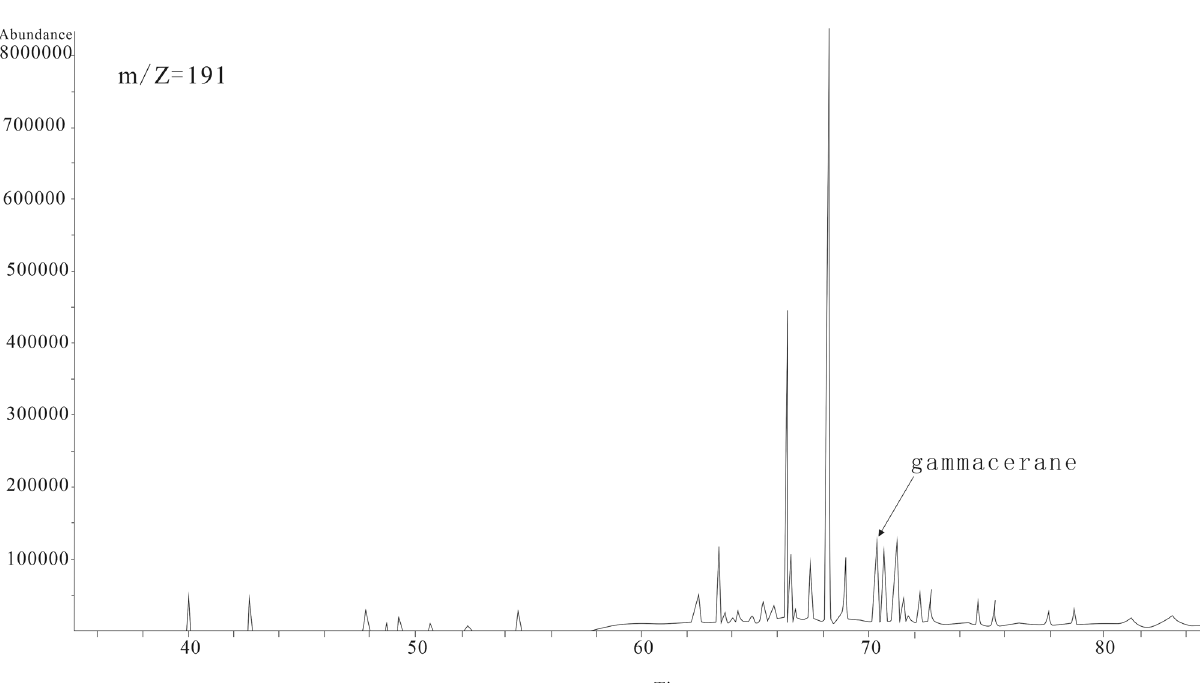
Figure 5. Mass spectrum of m/z =